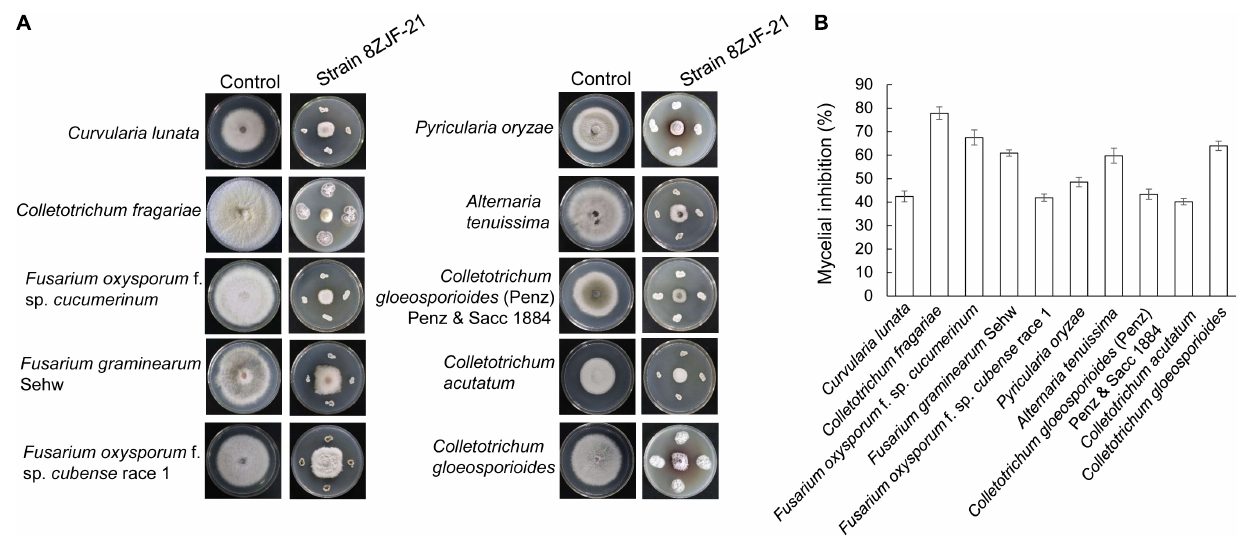
FIGURE 2 | Measurement of a broad-spectrum antifungal activity of S. malaysiensis 8ZJF-21 against the selected fungal phytopathogens. (A) Antagonistic assay of S. malaysiensis 8ZJF-21 against different phytopathogens. (B) Quantitative analysis of antifungal activity of S. malaysiensis 8ZJF-21 against different